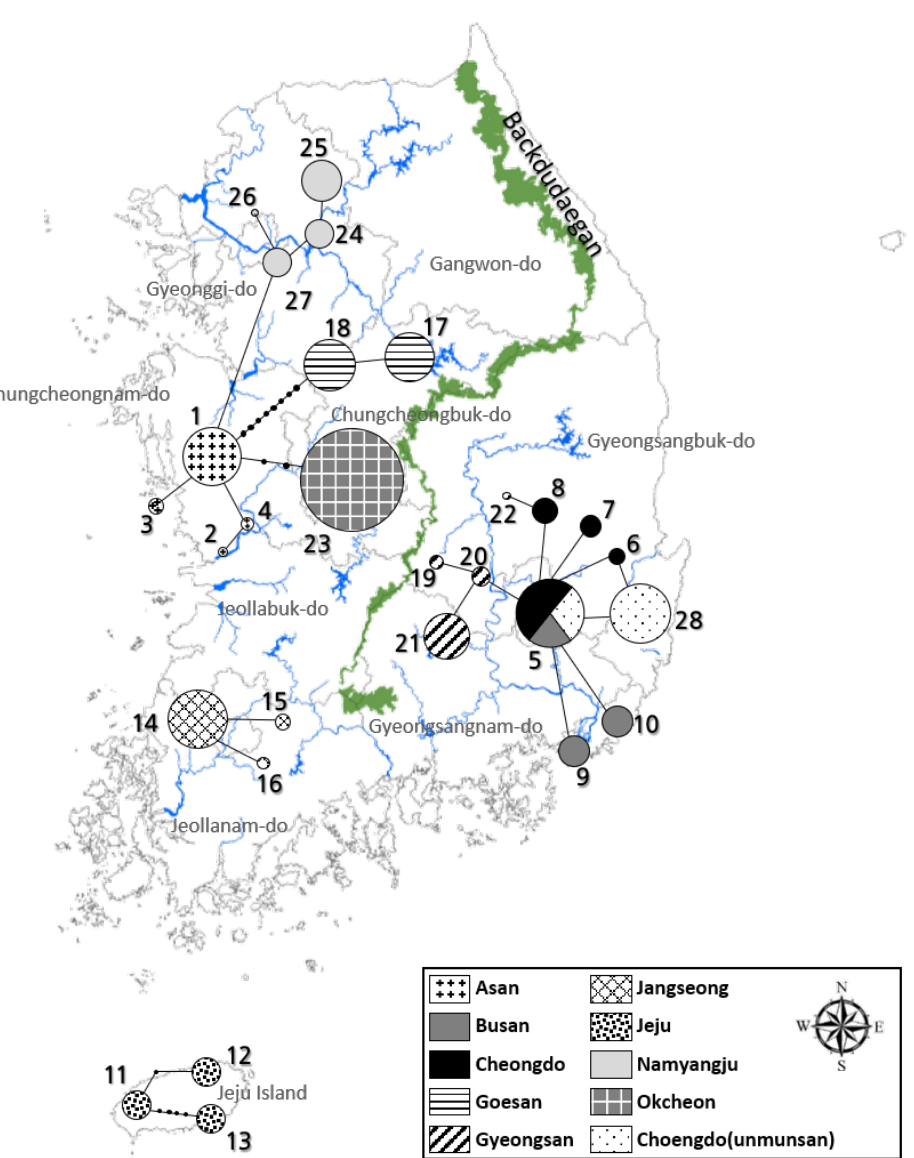
Figure 6. Haplotype network based on the mitochondrial DNA COII sequence of four local L. unmunsana groups.